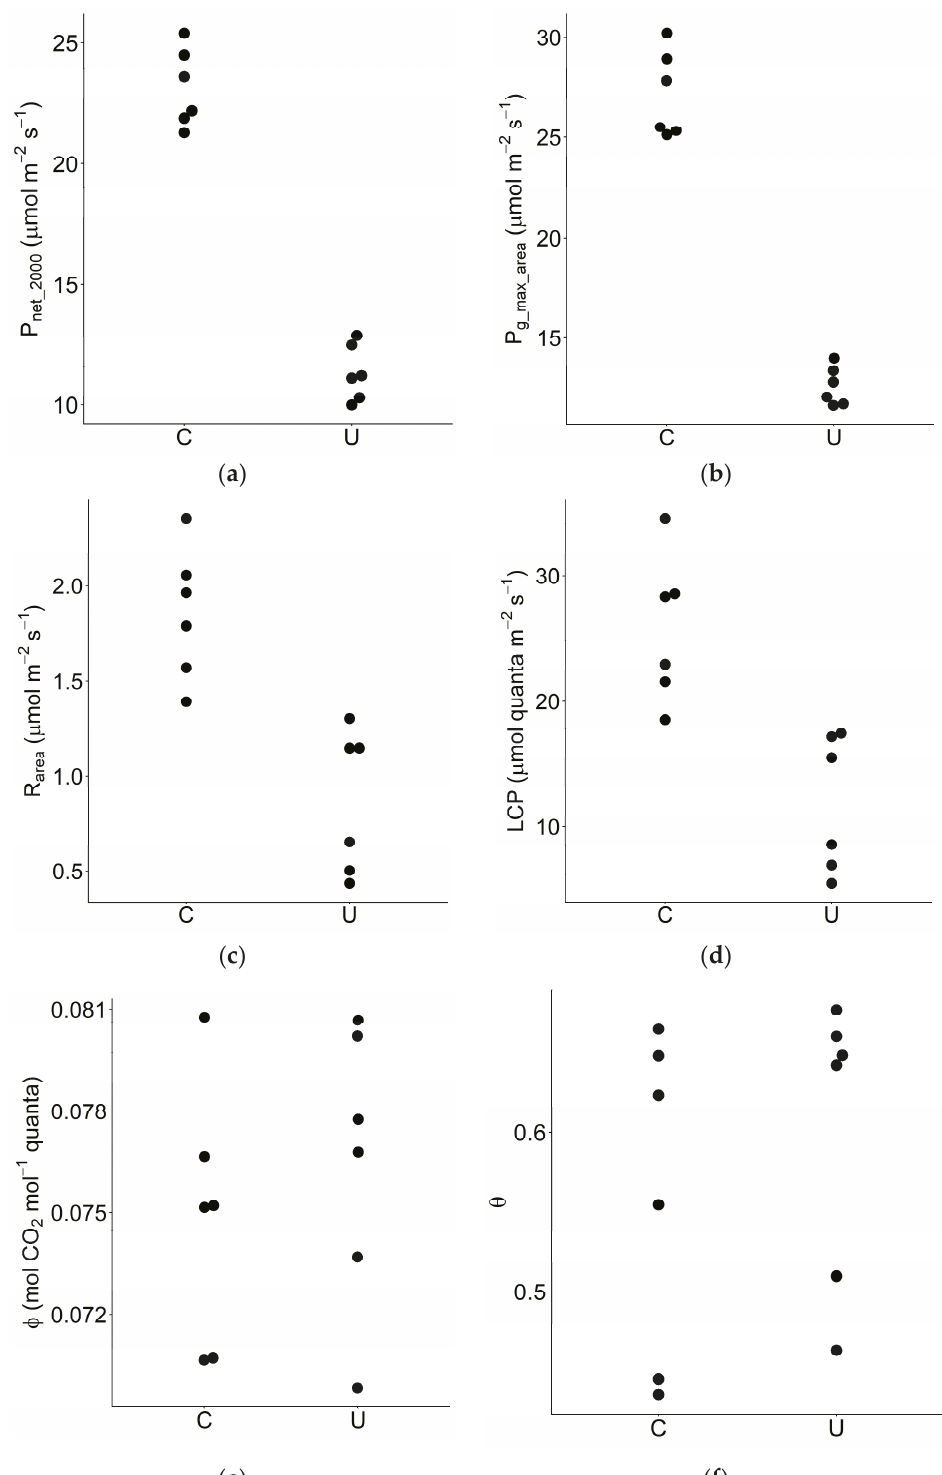
Figure 6. ( a – f ) Area-based photosynthetic parameters of the sun leaves in the clearing (C) and the shade leaves in the understory (U). Each closed circle indicates one leaf. LCP: light compensation